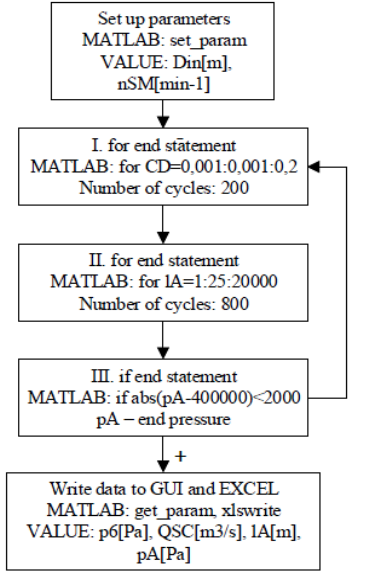
Fig. 4. Script flowchart of automatic solution mathematical model .